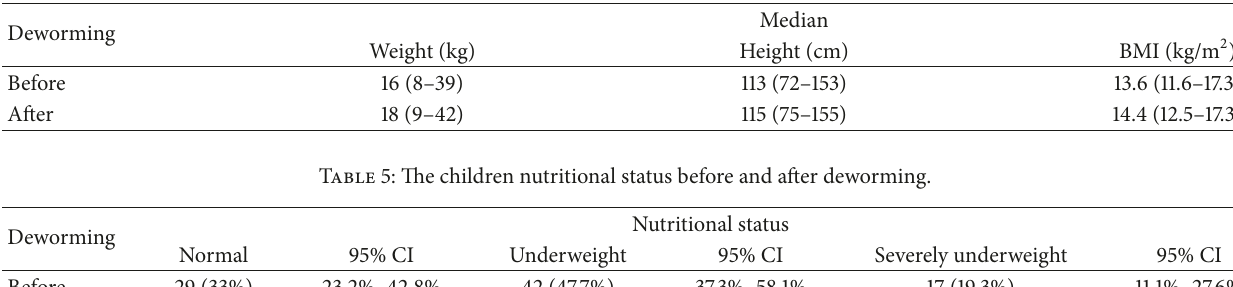
Table 4: The children anthropometry results before and after deworming.